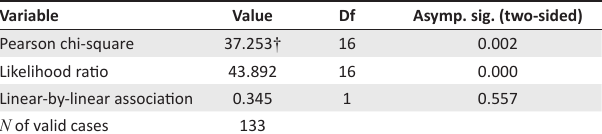
TABLE 2b: Chi-square